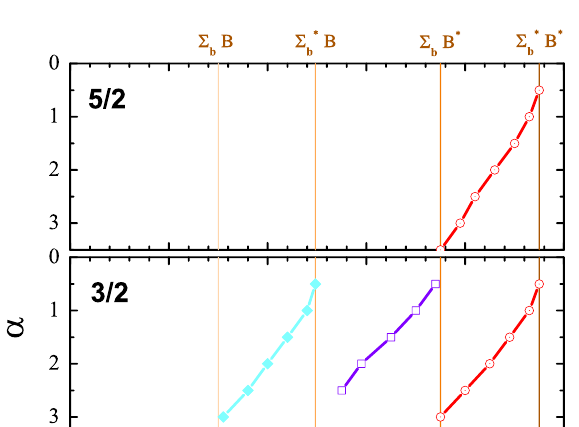
B ∗ , Σ b B ∗ , Σ ∗ B and Σ b B b b